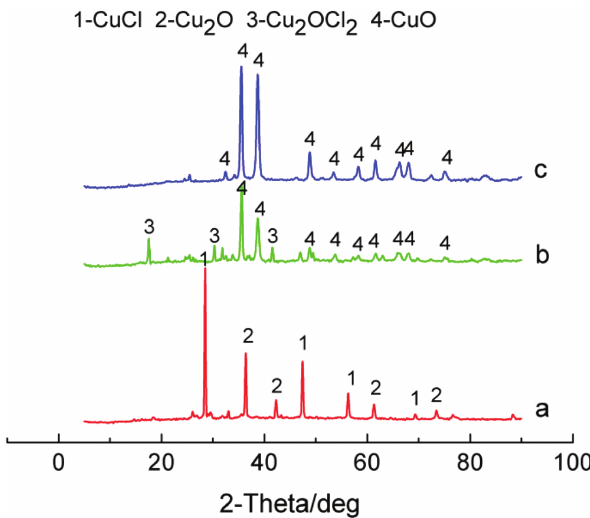
Figure 10: XRD patterns of products roasted by conventional and microwave roasting: a: raw material; b: conventional heating; c: microwave